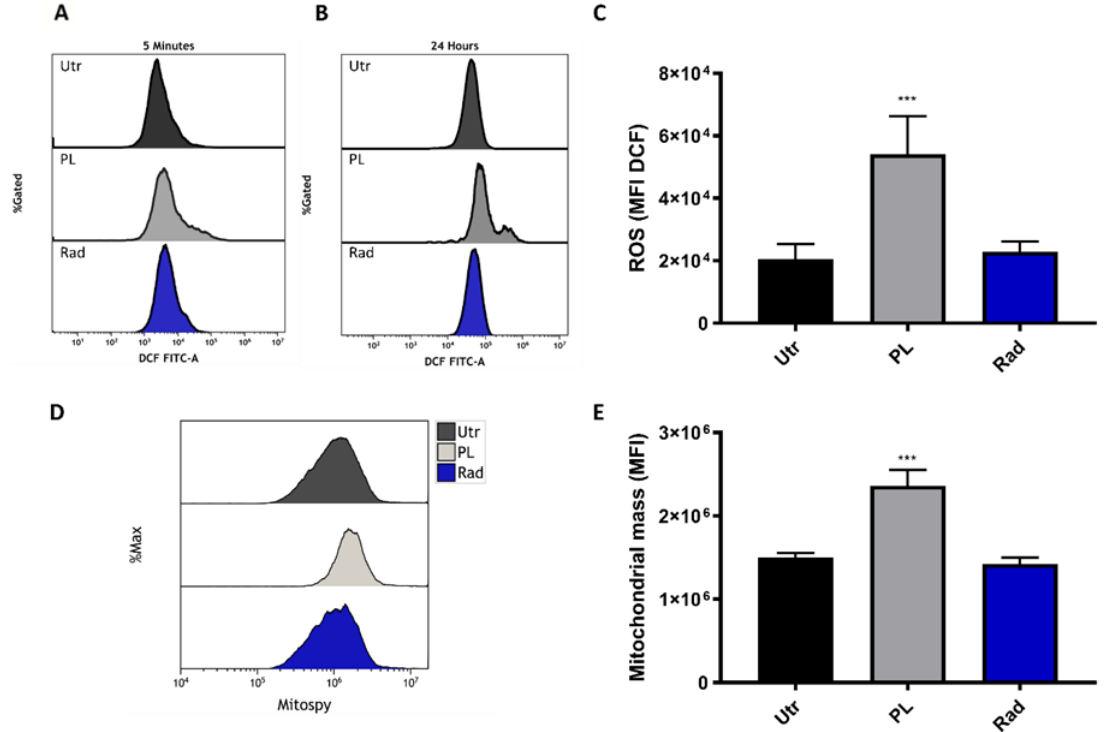
Figure 1. Gas plasma and radiotherapy introduced reactive oxygen and nitrogen species (ROS) in B16F10 melanoma cells. ( A – C ) B16F10 cells were exposed either to gas plasma (15 s) or radiotherapy (8 Gy), and intracellular ROS were measured immediately ( A ) and 24 h ( B ) after exposure by flow cytometry, and quantified ( C ); ( D , E ) mitochondrial mass was determined by flow cytometry ( D ) and quantified ( E ) at 24 h post-exposure. Data are representative and mean +SE of three experiments. Statistical analysis was performed by one-way ANOVA. Utr = untreated, PL = plasma, Rad = radiotherapy, MFI = mean fluorescent intensity; *** = p < 0.001.